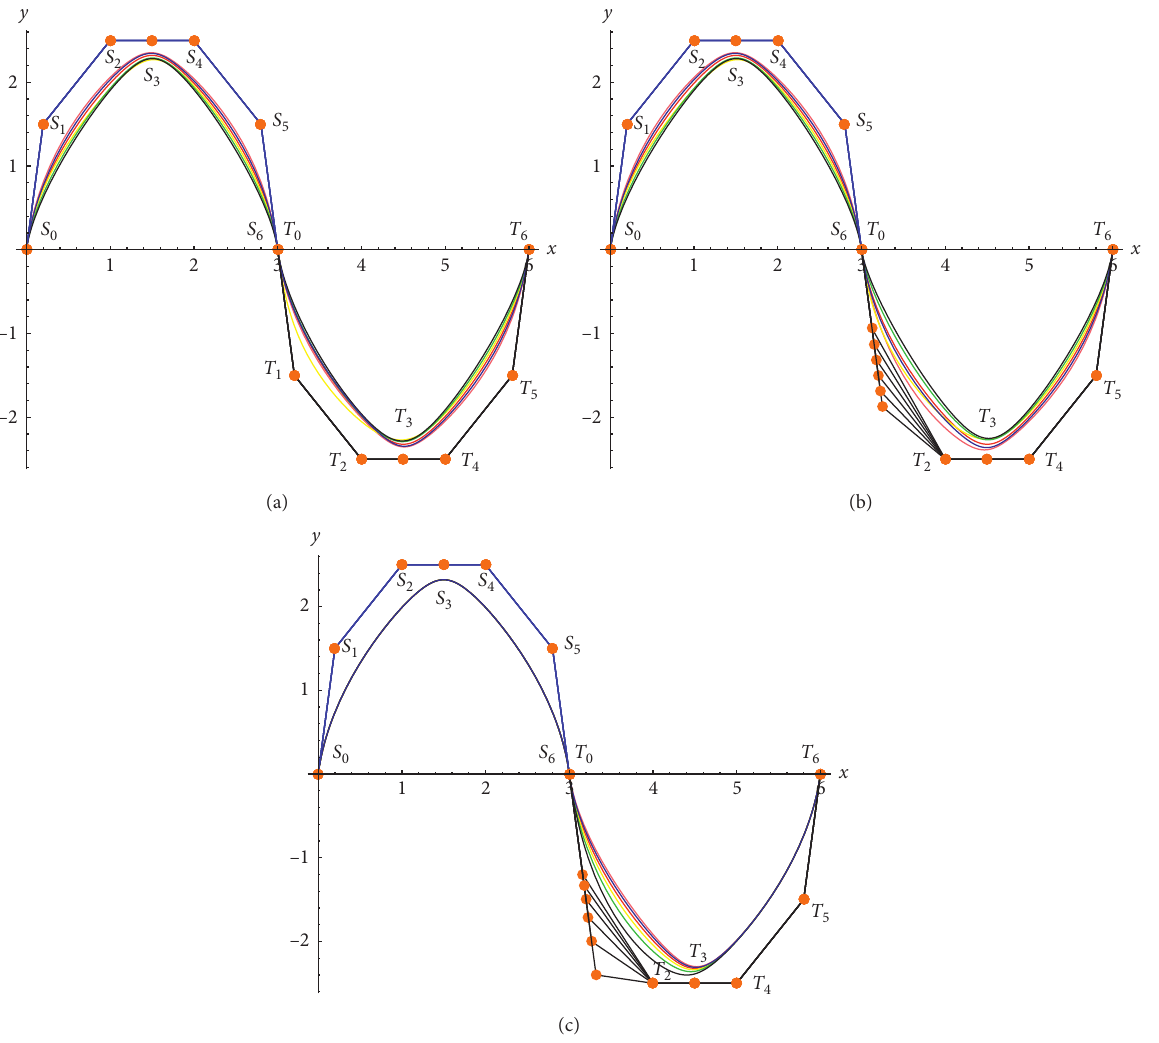
Figure 7: C 1 continuity of ST-B´ezier curve segments with various shape parameters. (a) μ � ω � μ 1 � ω 1 , 0 , 0 . 5 , 1 , − 0 . 5 , − 1 , − 1 . 5. (b) μ � ω � 0 , 0 . 5 , 1 , 0 . 5 , − 1 , − 1 . 5 , μ 1 � ω 1 � 0. (c) μ 1 � ω 1 � 0 , 0 . 5 , 1 , − 0 . 5 , − 1 , − 1 . 5 , μ 1 � ω 1 �